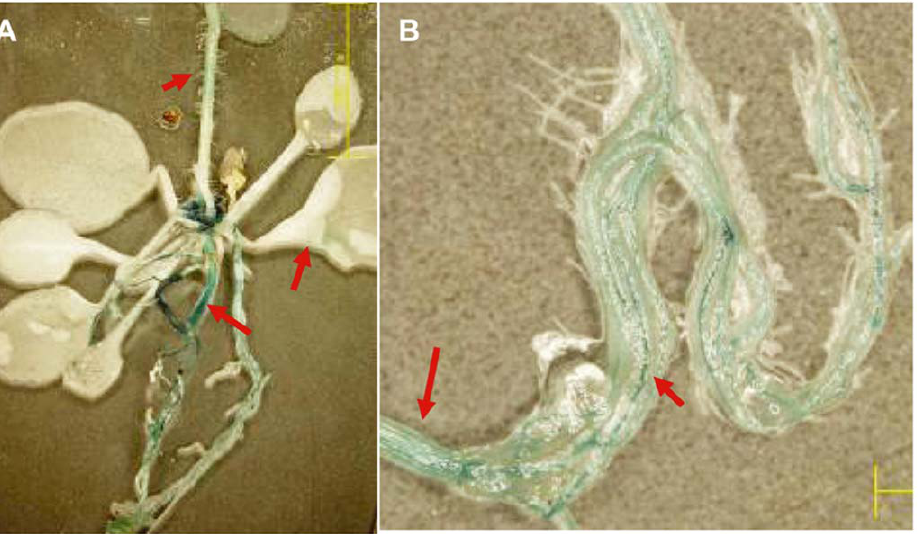
Figure 3. GUS activities in transgenic Arabidopsis plants containing the PGbve1:GUS construct. (A). GUS activities in the Arabidopsis plantlet. (B). Magnified view of vascular bundles in roots and stems.